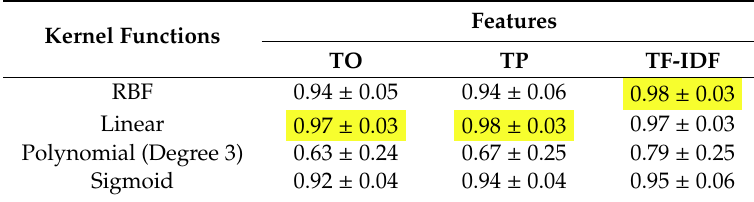
Table 4. Result of parameter tuning for support vector machine